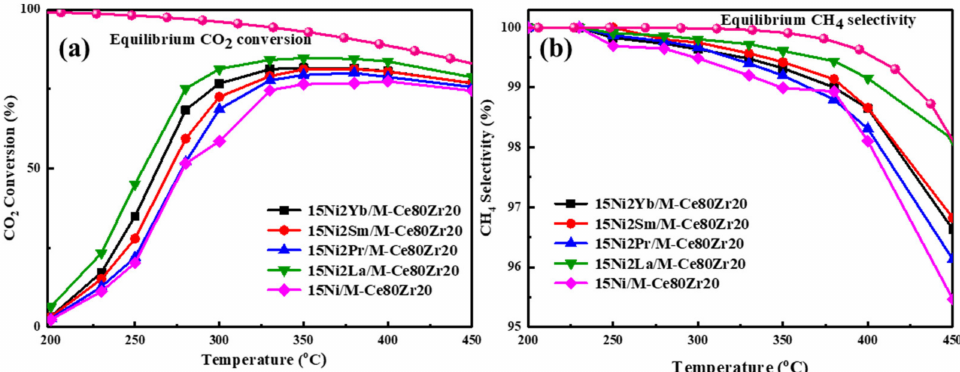
Figure 9. The curves of the ( a ) CO 2 conversion and ( b ) CH 4 selectivity versus reaction temperature over the 15Ni2R/M-Ce80Zr20 (R = La, Sm, Pr, Yb) catalysts; reaction condition: H 2 /CO 2 = 4, GHSV = 12,000 mL/(g · h), 1